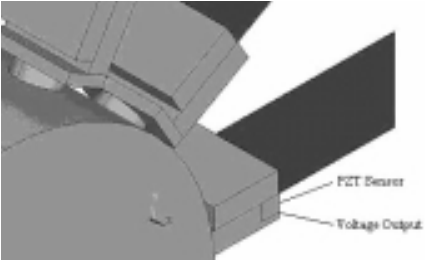
Fig. 2. PZT sensor zoomed.